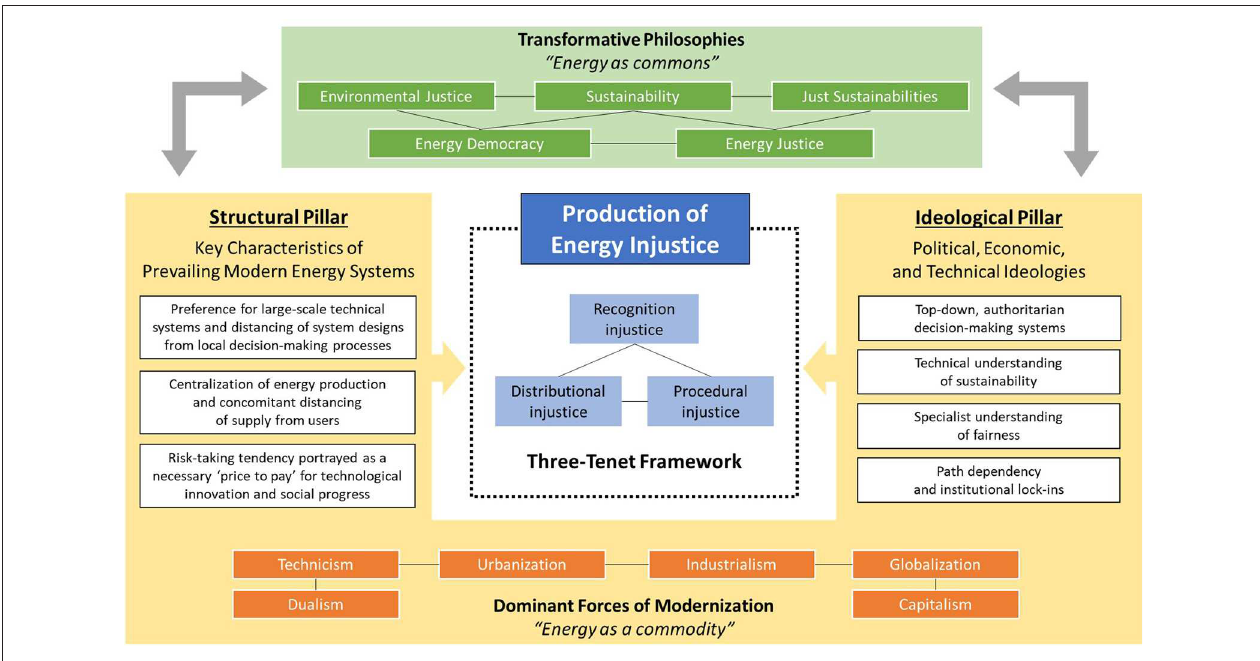
FIGURE 1 | Conceptual framework for understanding the production of systemic energy